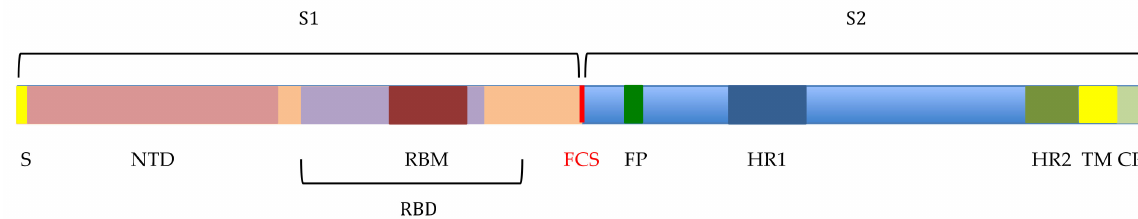
Figure 1. Molecular organization of the SARS-CoV-2 S-glycoprotein, made up of two linked S1 and S2 subunits that are further separated at the furin cleavage site (FCS). The S1 subunit consists of a signal peptide (S), followed by the N -terminal domain (NTD) containing the receptor-binding domain (RBD) interacting with the ACE2 receptor via the RBM motif (RBM). The S2 subunit comprises the fusion peptide (FP), two heptad repeats HR1 and HR2, the transmembrane spanning domain (TM) that anchors the S protein into the virion membrane, and the cytoplasmic domain